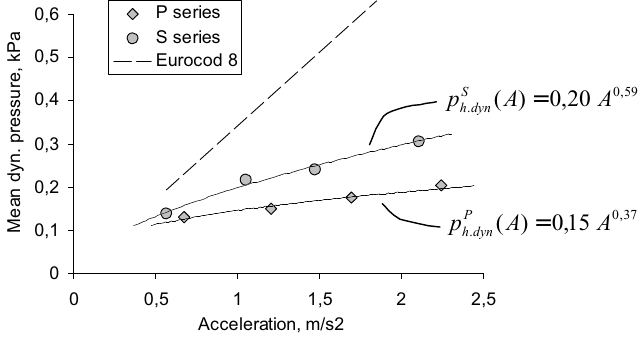
Fig. 11. Relationship of mean dynamic pressure-acceleration